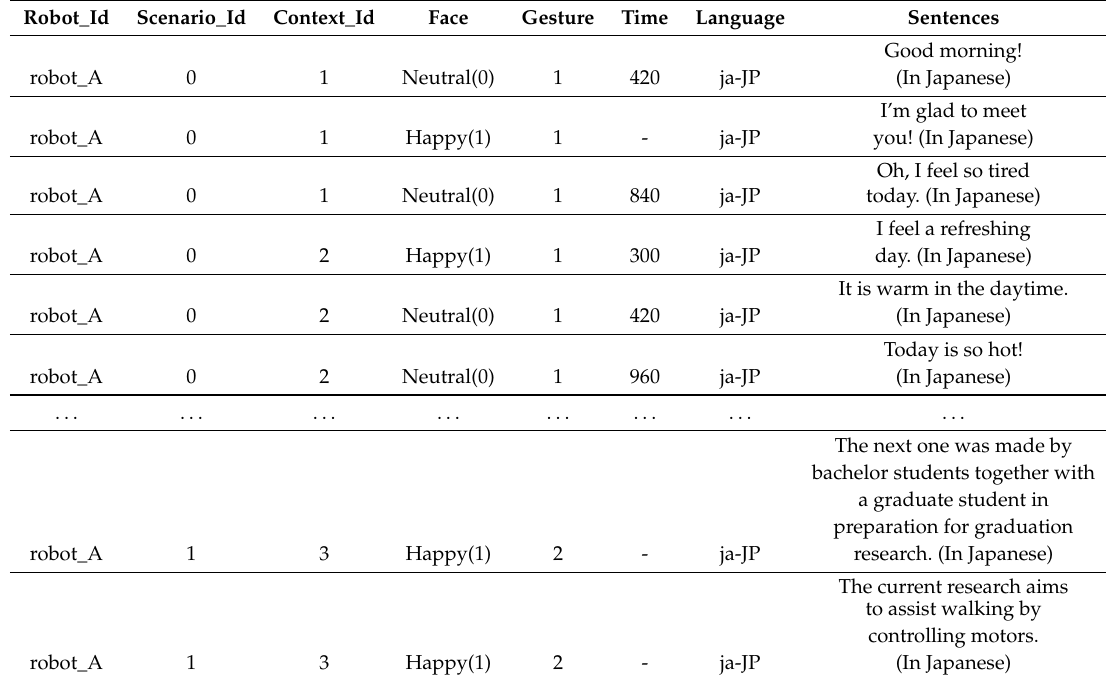
Table 3. Interaction design template for robot partner